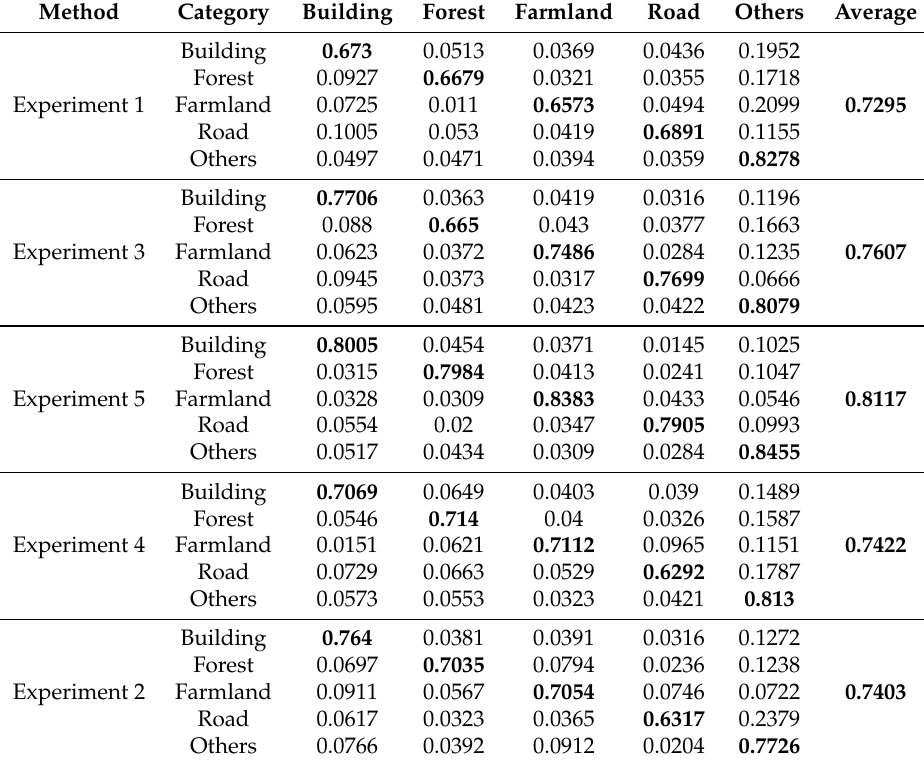
Table 4. Confusion matrix for the classification results of TerraSAR